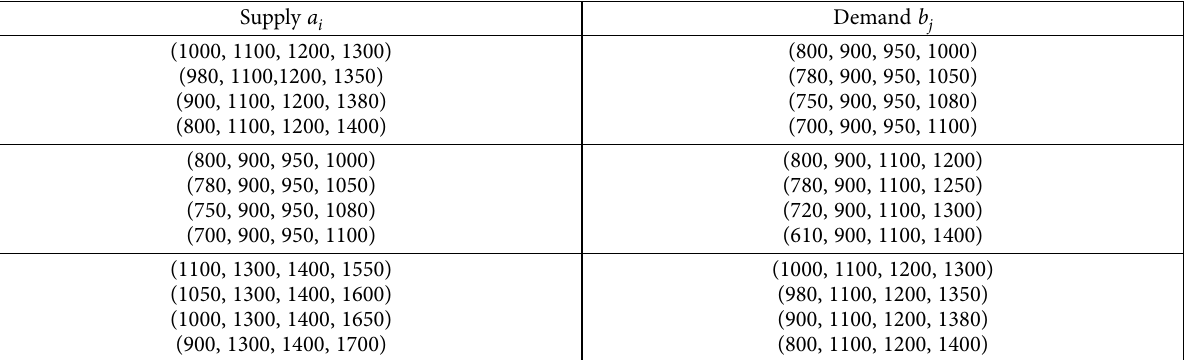
Table 5. Imprecise demand and supply